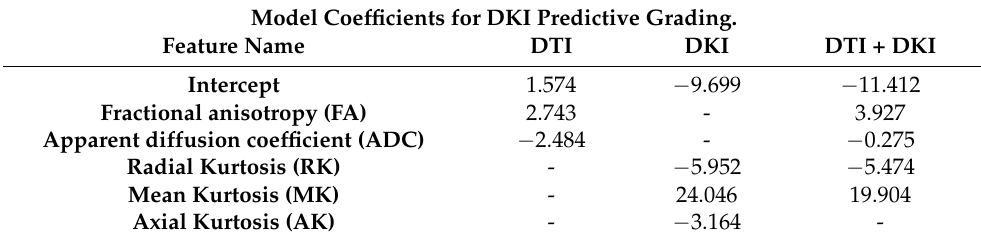
Table 3. The model coefficients for each analysis model (DTI-only based, DKI-only based, and combined DTI and DKI) are summarized in Table 3. The model coefficients were used to calculate the predicted probability of having a pHGG for each patient. pHGG: pediatric high-grade gliomas; DKI: diffusion kurtosis